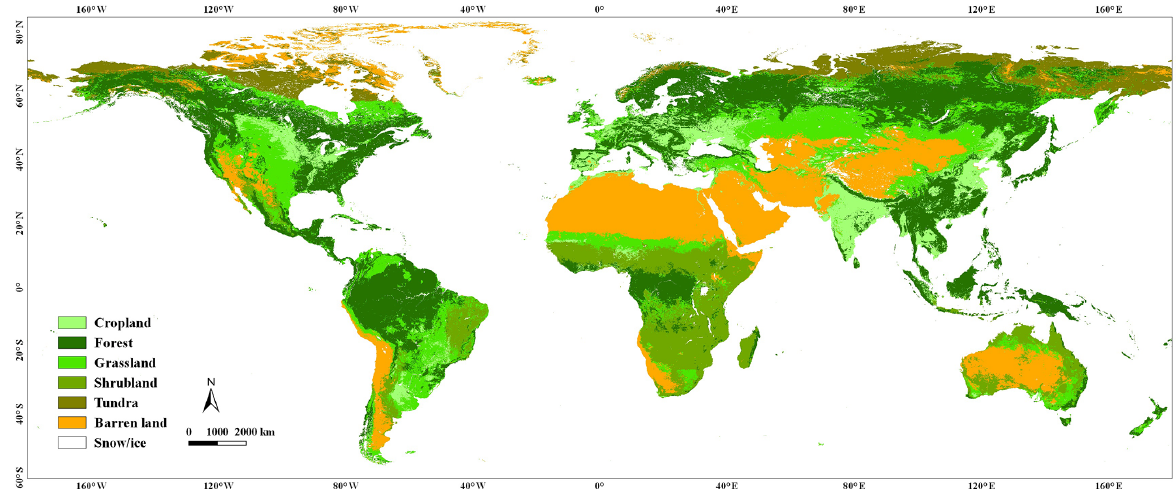
Figure 3. GLASS-GLC (annual dynamics of global land cover) CDRs (climate data records) results in 2015.